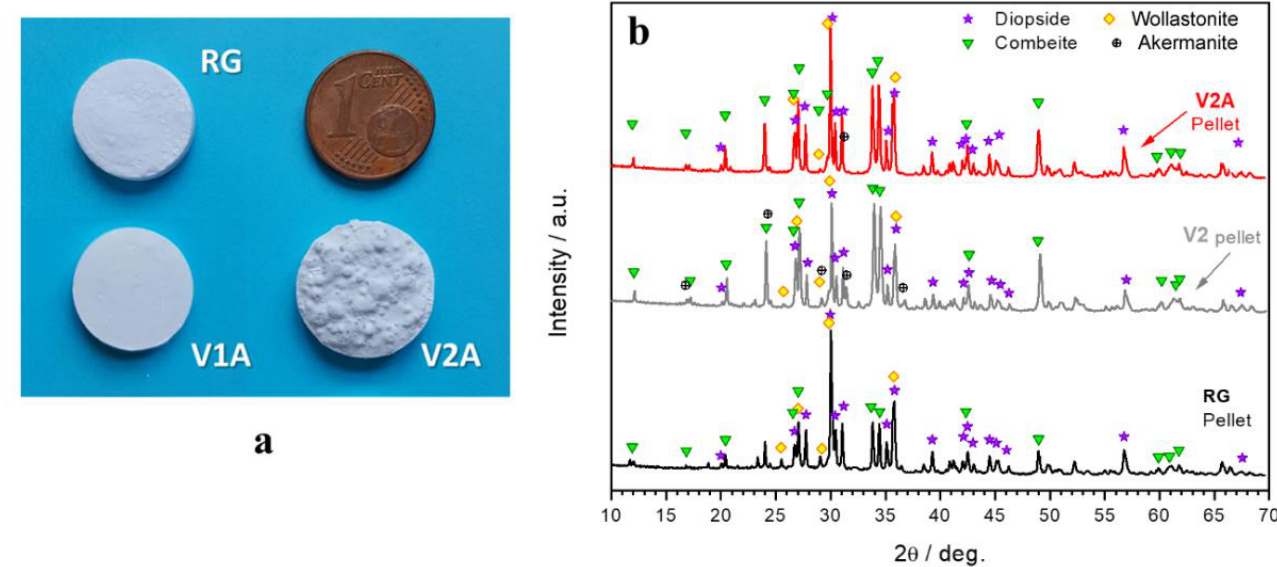
Figure 3. ( a ) Examples of glass–ceramic pellets (fired in air); ( b ) comparison between